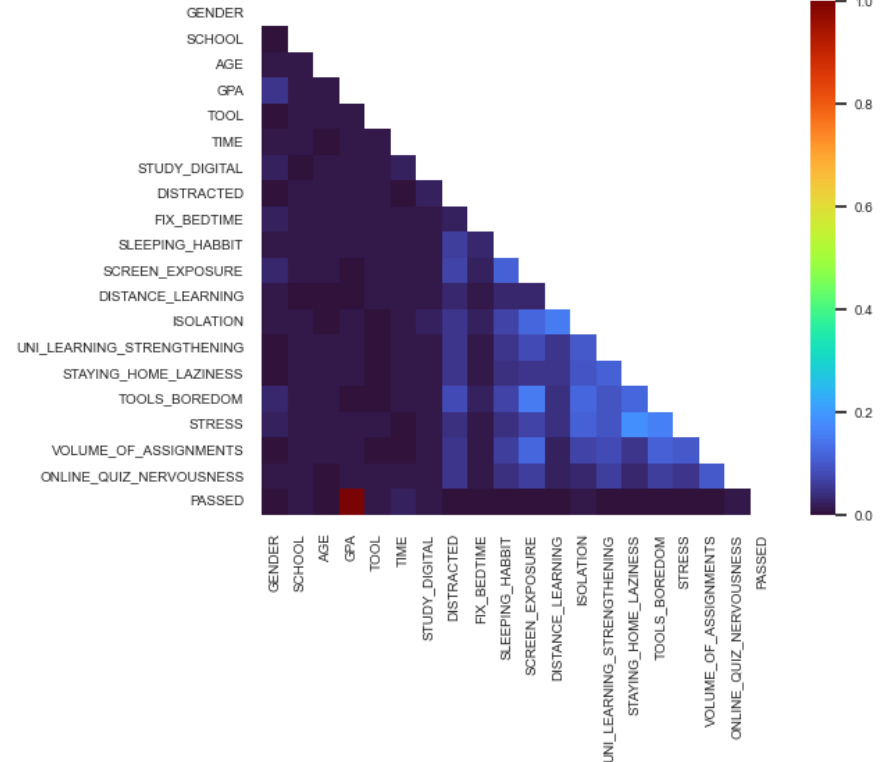
Figure 5. Cramer’s V